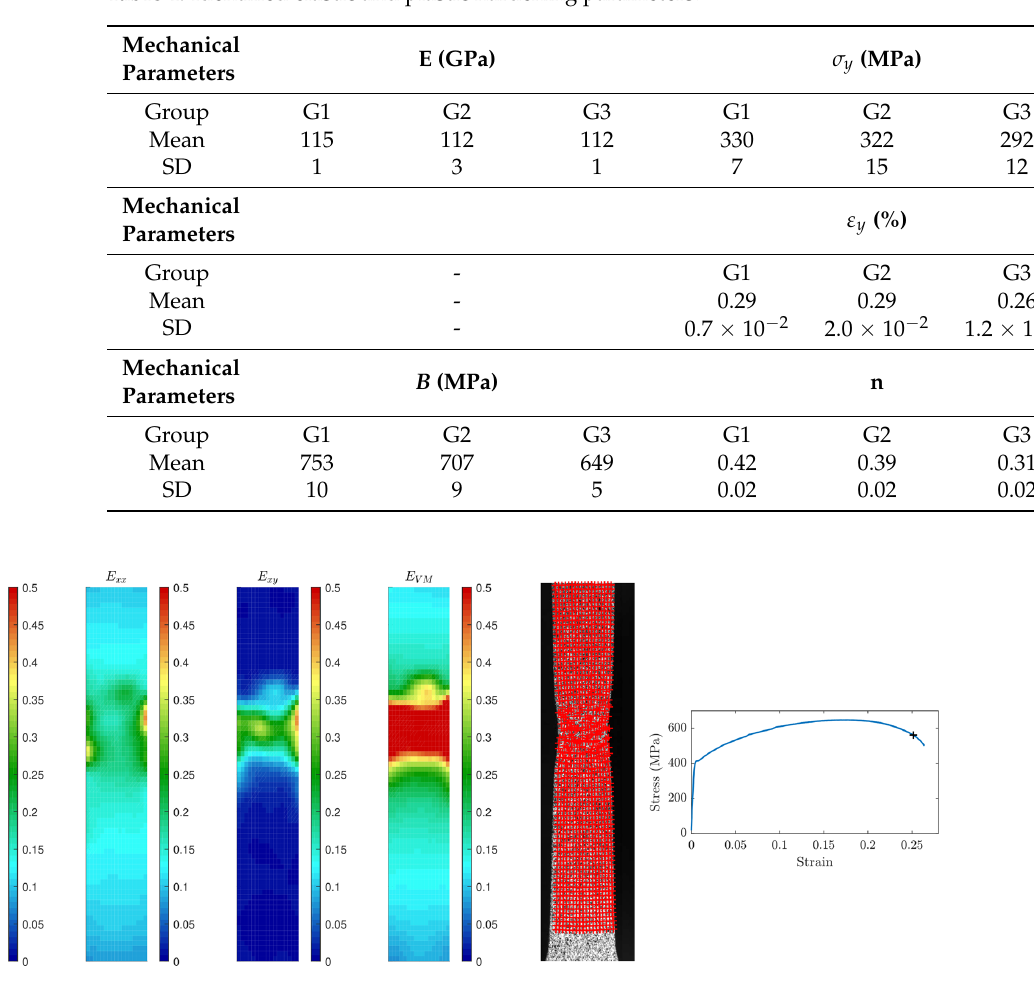
Figure 6. Strain representation (( a ) E yy , ( b ) E xx , ( c ) E xy , ( d ) E VM ) on a specimen, ( e ) grid representation of sample after plastic deformation. ( f ) Strain–stress curve showing elastoplastic